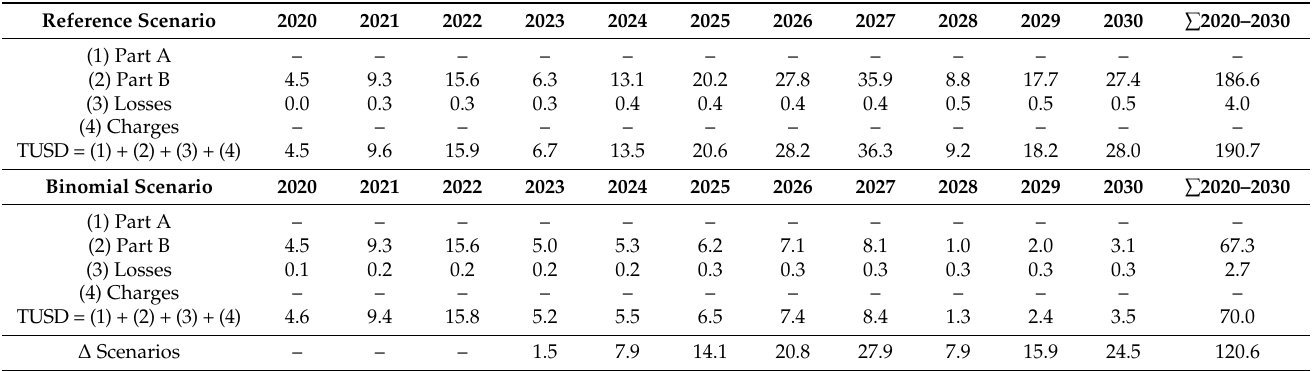
Table 13. Irrecoverable portion of MMDG for Enel Goi á s, in million